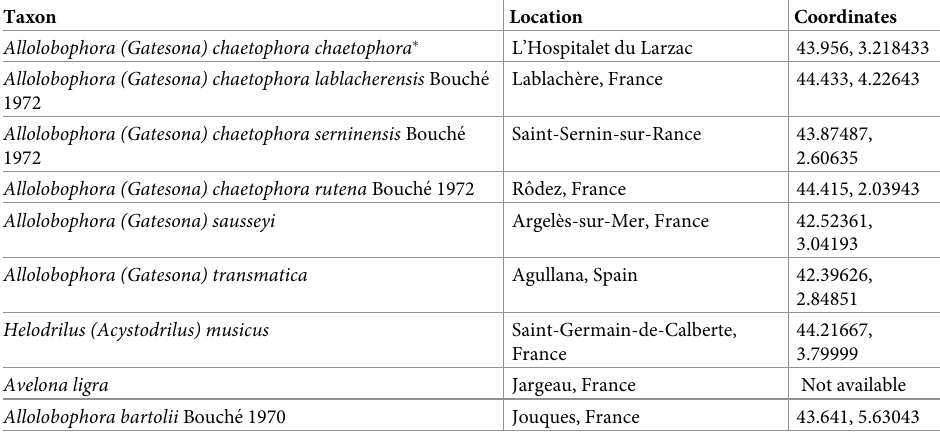
Table 1. Species sampled and sequenced in this study, with their sampling location and coordinates. Taxon